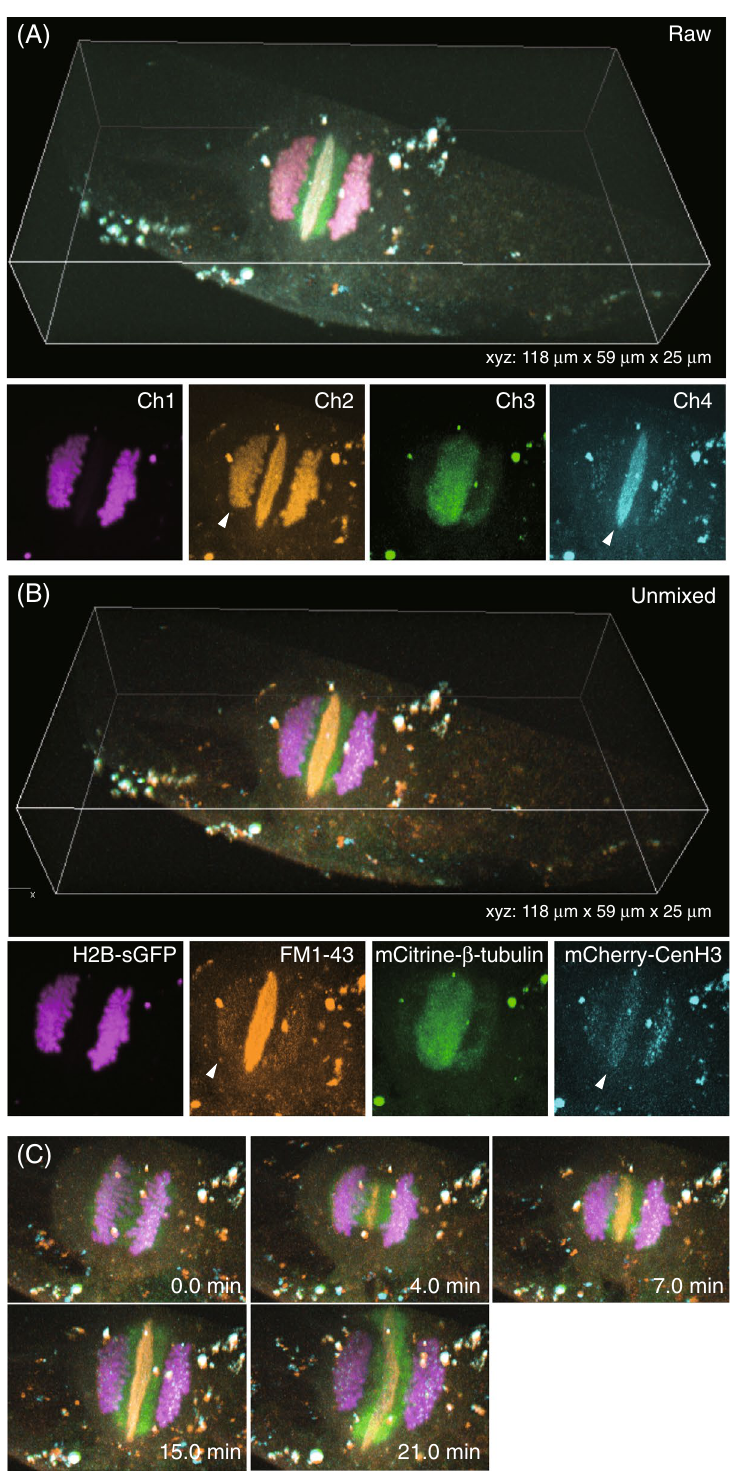
Figure 4. The xyzt-λ images of 4-color labeled tobacco BY-2 cells undergoing mitosis, as measured by the TPLSM-SD system. ( A ) Raw images at the timepoint of 15.0 min. Arrowheads representing leaking signals due to inter-channel cross-talks. ( B ) Calculated images by a linear unmixing method. Arrowheads representing the area where the leaking signals were decreased. ( C ) Time-lapse images of cell divisions during mitosis. Z -stacks (25-µm-thick) were taken at 0.5-µm intervals. In each sectioned image, the exposure times for both 960-nm and 1040-nm excitation were 300 ms. The total time for xyz-λ image acquisition was 44 s, while the volume time-lapse interval was 60 s for 23-min measurements. The averaged laser power at the position of specimen for 960-nm and 1040-nm excitations were 122 mW and 37 mW,